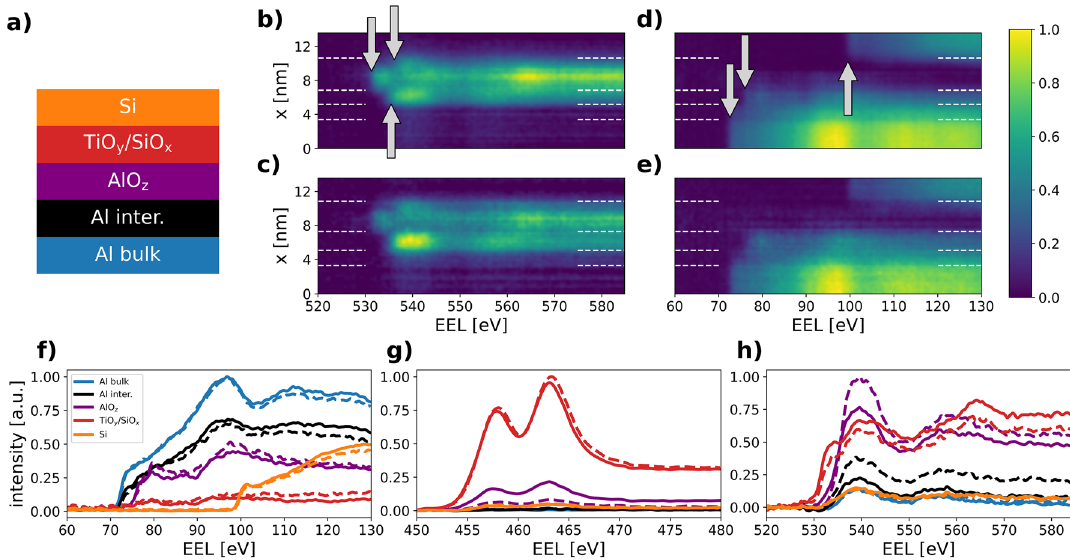
Figure 3. EELS results obtained from the rear contacts. ( a ) Depicts a schematic of the layers obtained by cluster analysis. ( b–e ) Show spectrum images over the contact region for ( b ) the O K-edge and ( d ) the Al/Si L-edge of the as deposited sample and ( c,e ) displaying the respective edges for the annealed sample. The edge onset energies are marked with arrows in ( b,d ). Interfaces of the layers given in ( a ) are indicated by white dashed lines in ( b–e ). The mean EEL spectra of these layers are presented in ( f–h ), where solid and dashed lines refer to the as-deposited and annealed state, respectively, and colors are in accordance with ( a ). ( f ) Shows the Al L 2,3 /Si L 2,3 energy range, ( g ) shows the range around the Ti L 2,3 edge and ( h ) shows the range around the O